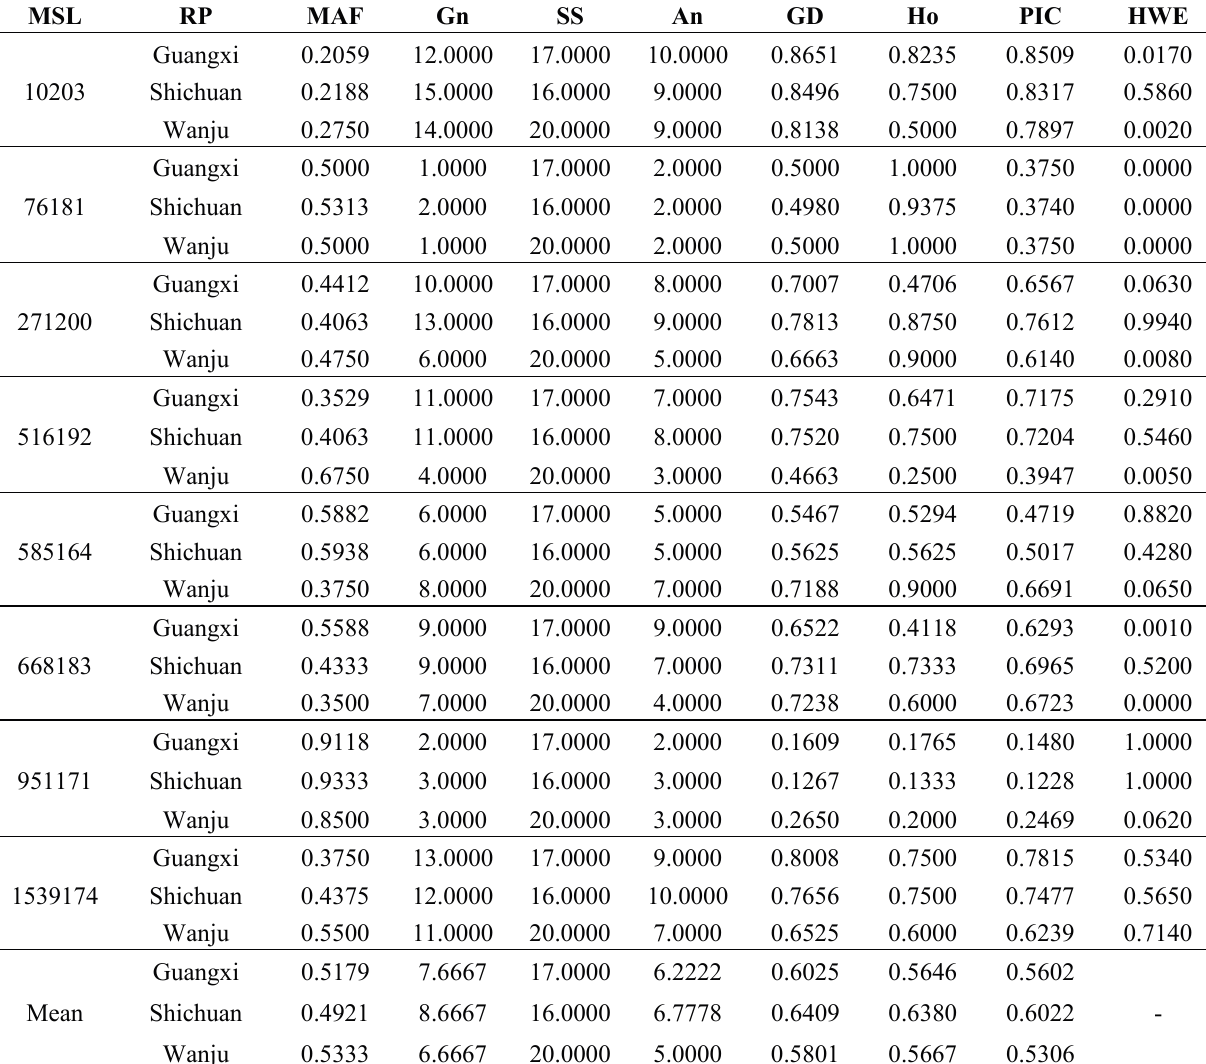
Table 3. Characteristics of eight polymorphic microsatellites loci developed in three regional populations of Dorcus hopei (MSL, Microsatellite locus; RP, Regional population; MAF, Major allele frequency; Gn, Genotype number; SS, Sample size; An, Allele number; GD, Gene diversity; Ho, Observed heterozygosity; PIC, Polymorphism information content; HWE, Exact p -value of Hardy-Weinberg